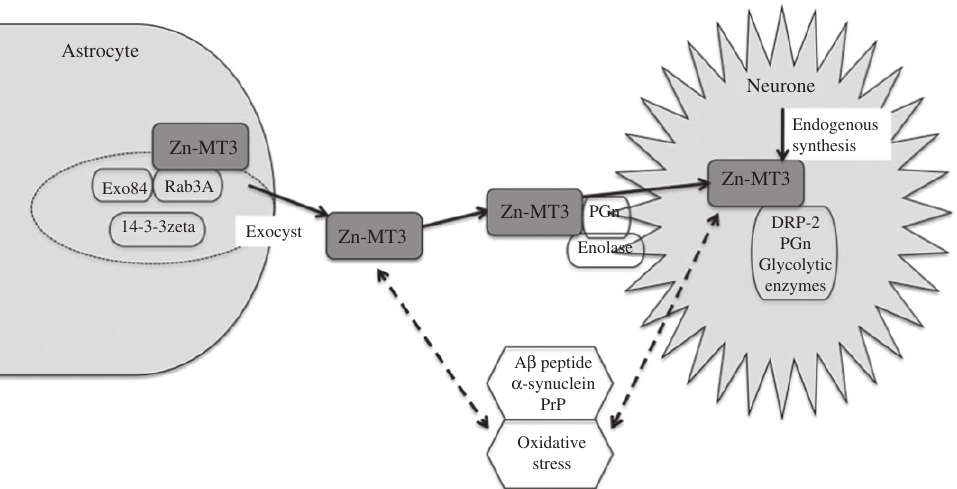
Figure 3 Schematic representation of the localization and protein interactions of the Zn-MT3 complexes reported in the astrocyte, neuron, and intracellular matrix of mammalian CNS, adapted from ref. (47) .